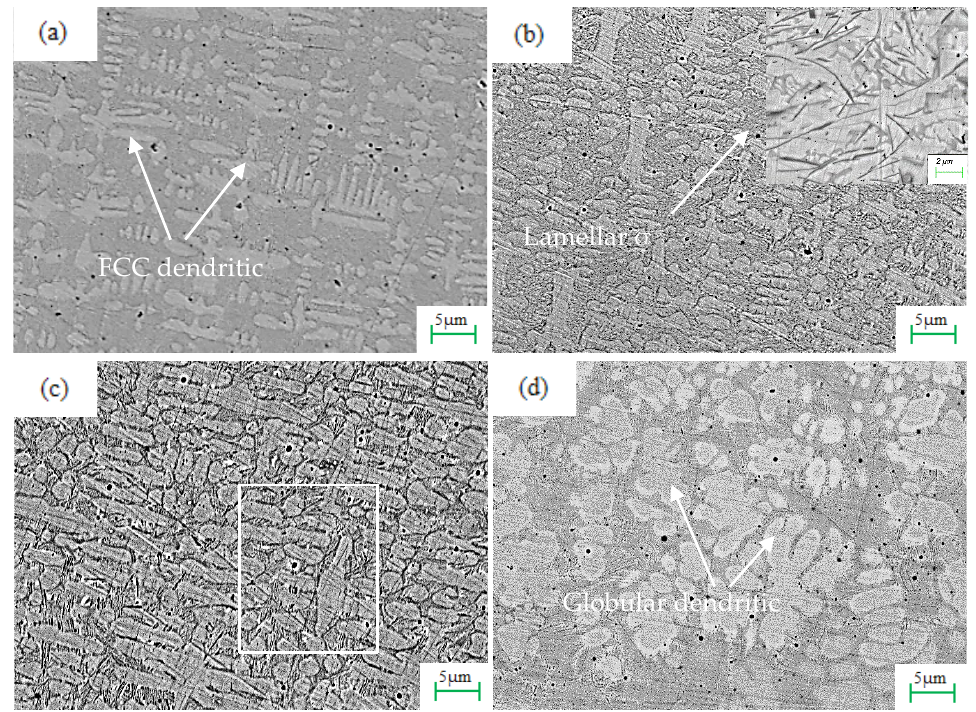
Figure 6. Morphologies at the middle of coatings on the cross section. ( a ) CoCrNi, ( b ) CoCrNiMo 1 , ( c ) CoCrNiMo 3 and ( d ) CoCrNiMo 5.